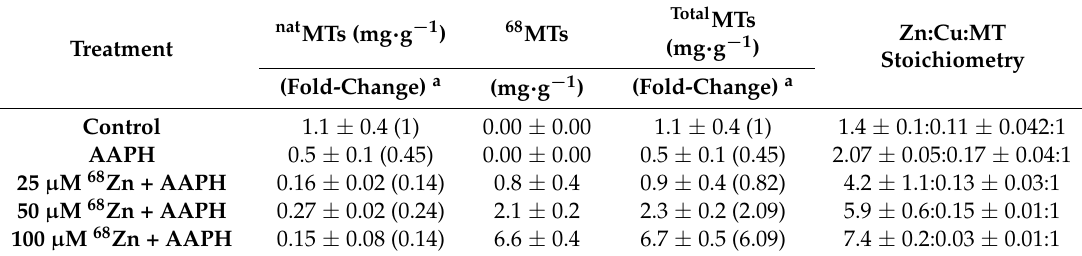
Table 4. Concentration of MTs (in mg of MTs per g of protein) labeled with nat MTs (natural contribution of zinc), 68 MTs (exogenous contribution of zinc) and Total-Zn-MTs (sum of both natural and exogenous contributions), in HRPEsv cells. Cells were cultured for 24 h in the absence (control) or presence of 68 ZnSO µ M) following exposure to 5 mM of AAPH for 1 h. The concentration of 4 (at 25, 50 or 100 MTs containing nat Zn and 68 Zn was determined by ID-,IPD-SEC-ICP-MS. Total protein level (in mg) in HRPEsv cell extracts was determined by BCA assay kit. The elemental stoichiometric composition of the MTs complexes was calculated by the determination of the S to metal (Zn and Cu) ratio, i.e.,